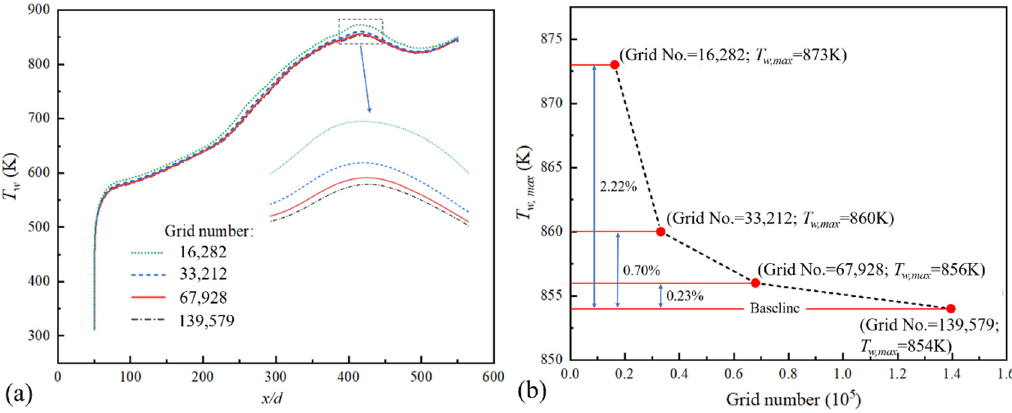
Figure 4. Comparison of wall temperature calculated by four grid systems: ( a ) axial wall temperature distributions; ( b ) maximum wall temperature.